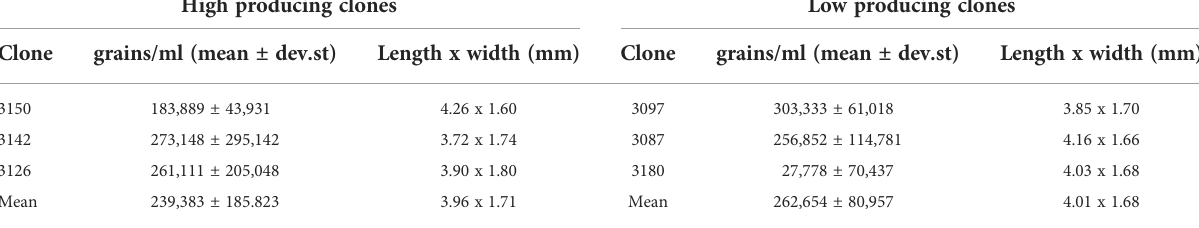
TABLE 4 Mean number and standard deviation of the number of pollen grains per cone counted in high and low producing C. sempervirens clones.